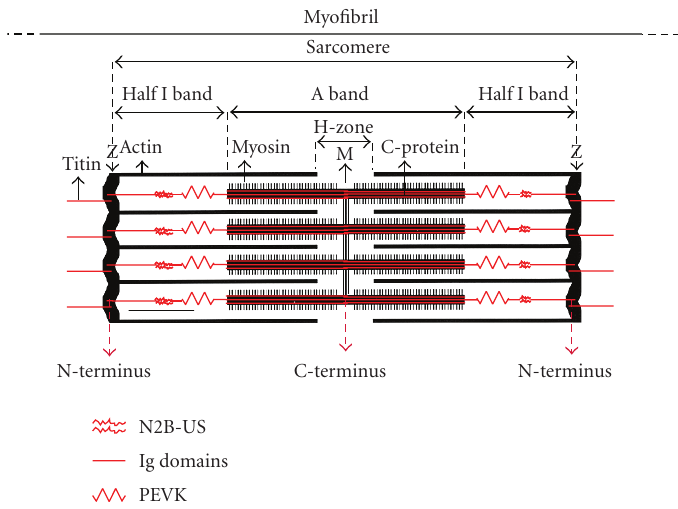
Figure 1: Titin location and arrangement in the cardiac